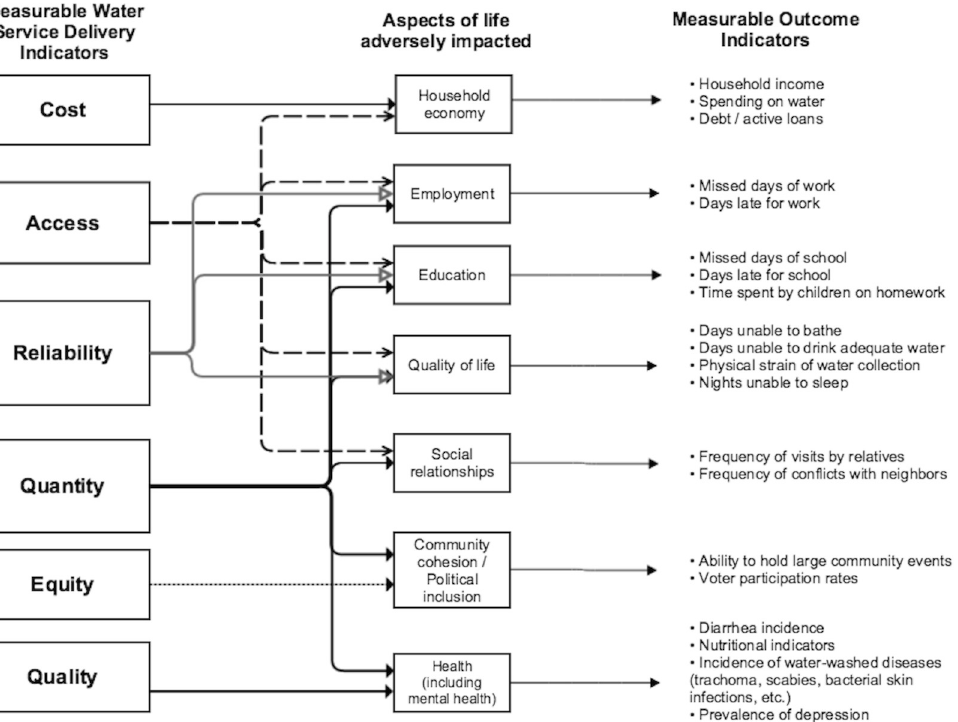
Fig 2. The relationships among water service delivery failures and adverse life impacts based on the qualitative findings. This diagram may also serve as a multidimensional framework for defining and evaluating household-level “ water poverty ” in